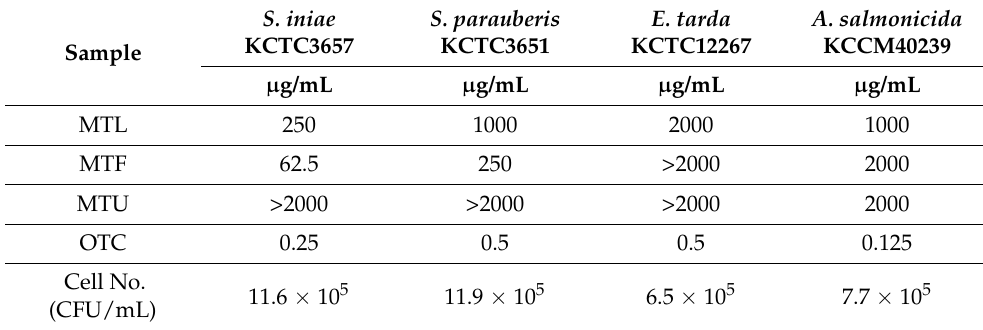
Table 3. Antibacterial activities of M. tricuspidata extracts against fish pathogenic bacteria.